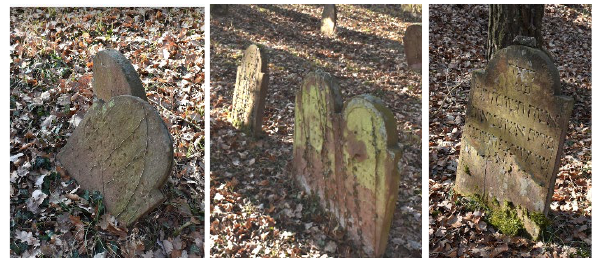
Figure 2. Samples of the damaged gravestones in